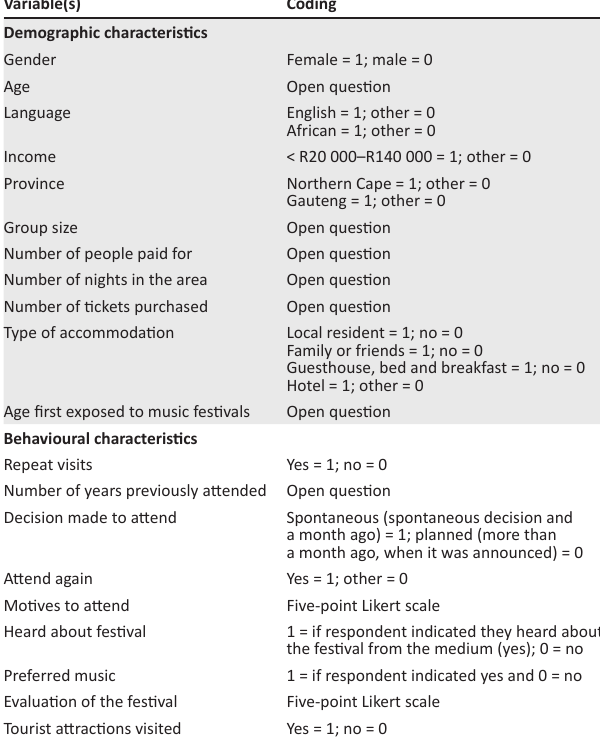
TABLE 2: Recoding of dummy variables used for Diamonds and